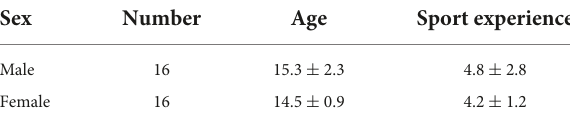
TABLE 1 Information of